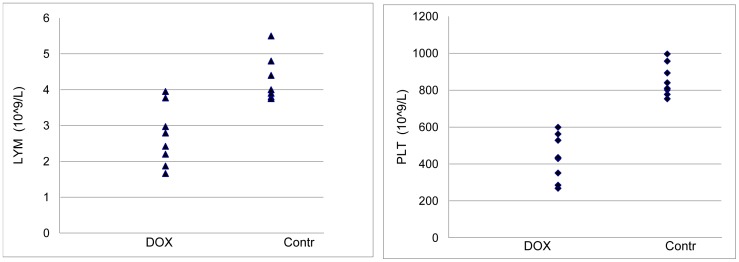
Lymphocytopenia (A) and thrombocytopenia (B) in rats 48 hours after administration of 12 mg/kg DOX.
P<0.05.